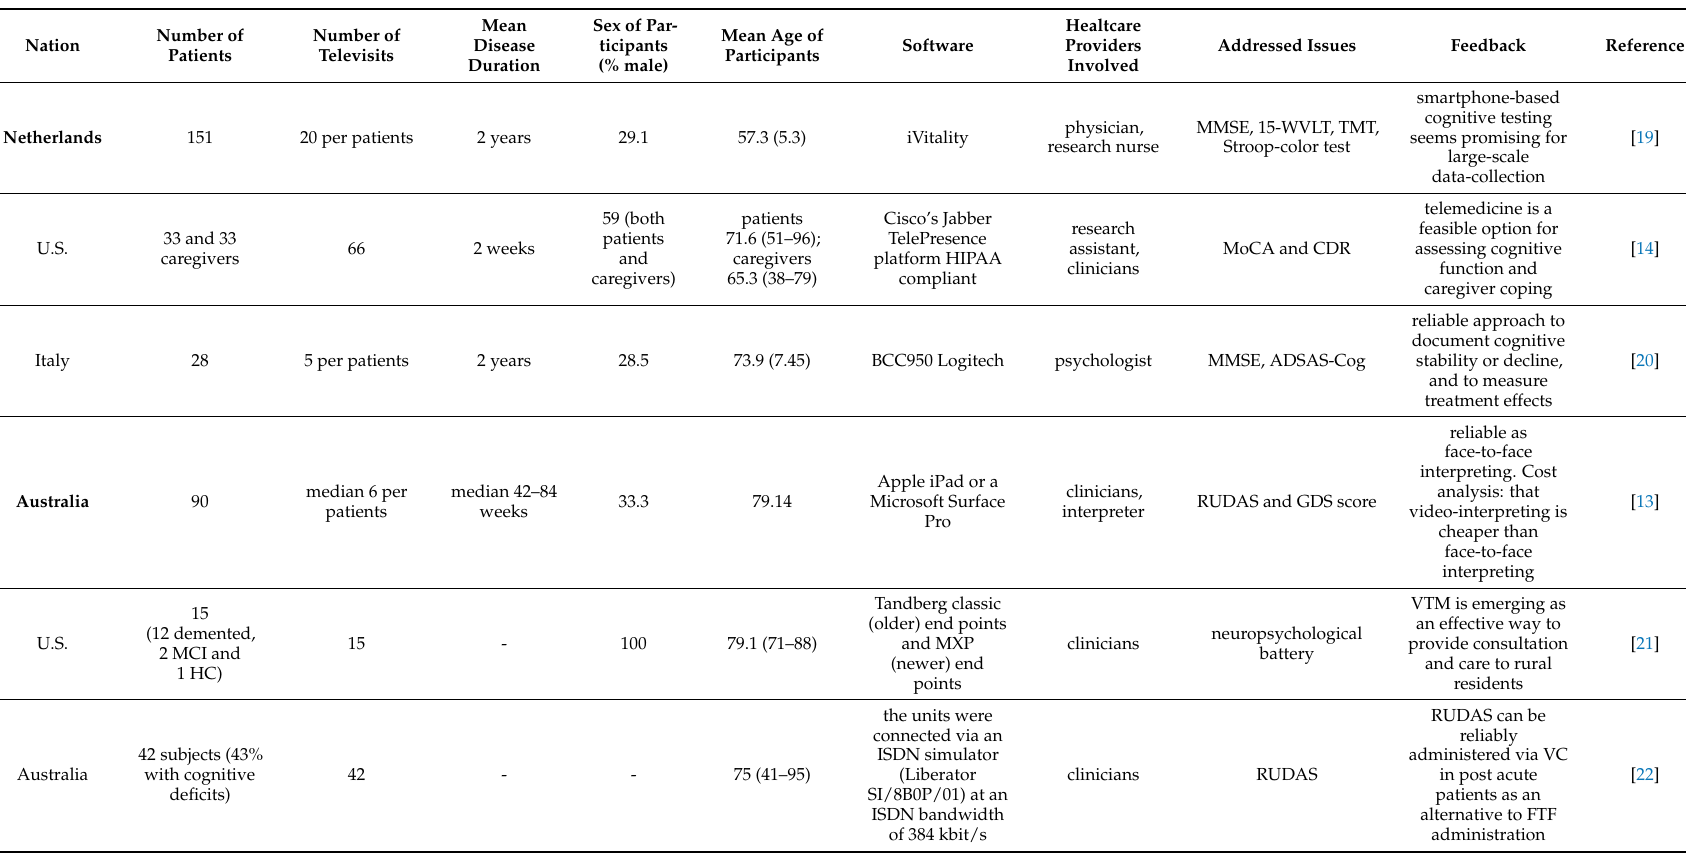
Table 2. Telemedicine studies in dementia. Continuous variables are expressed as mean (SD or confidence interval) unless otherwise specified. Abbreviations: U.S.: United States; AD: Alzheimer’s Disease; MCI: mild cognitive impairment; HC: healthy control; VC: videoconference; FTF: face-to-face; MMSE: Mini-Mental State Examination; 15-WVLT: 15-Word Verbal Learning Test; TMT: Trail making test; HIPAA: Health Insurance Portability and Accountability Act; MoCA: Montreal Cognitive Assessment; CDR: Clinical dementia rating scale; ADSAS-Cog: Alzheimer’s Disease Assessment Scale–Cognitive Subscale; RUDAS: Rowland Universal Dementia Assessment Scale; GDS: Geriatric Depression Scale; RBANS: Repeatable Battery for the Assessment of Neuropsychological Status; ED: emergency